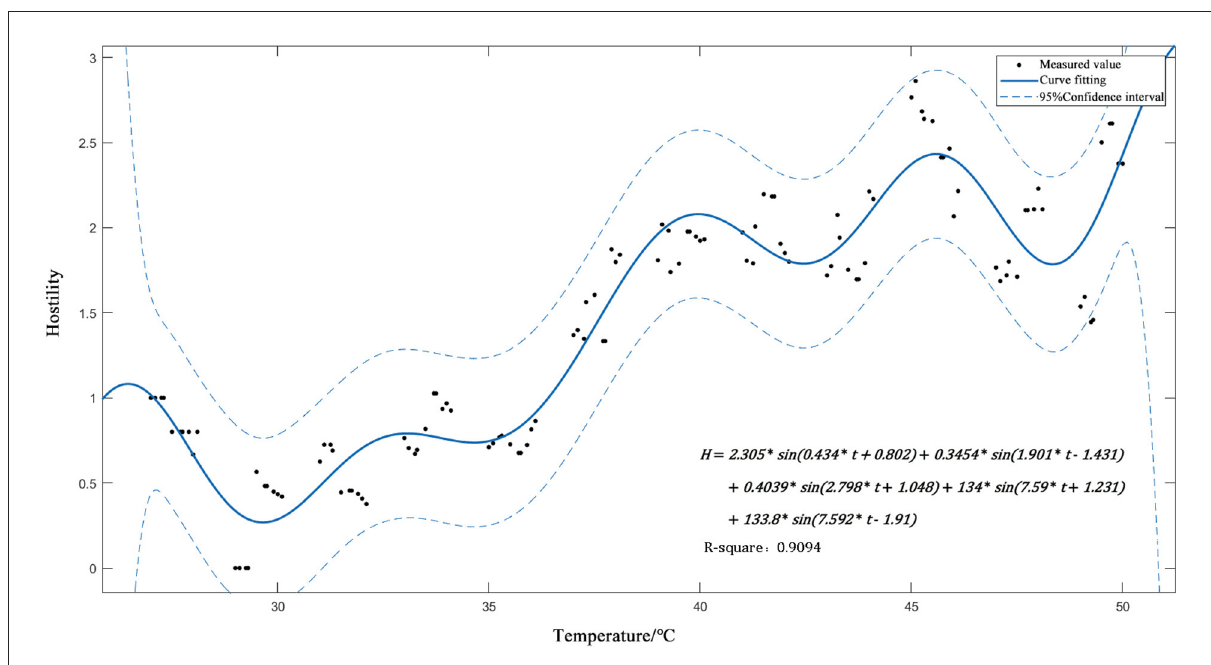
FIGURE5 Relationship model between instantaneous temperature and hostility.